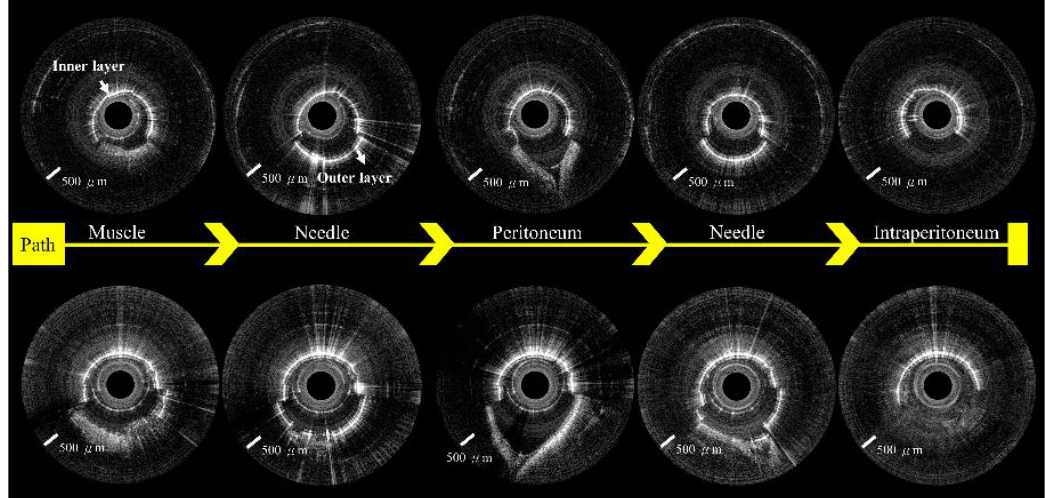
Figure 8. OCT images show the puncture path from the midline of the abdomen.